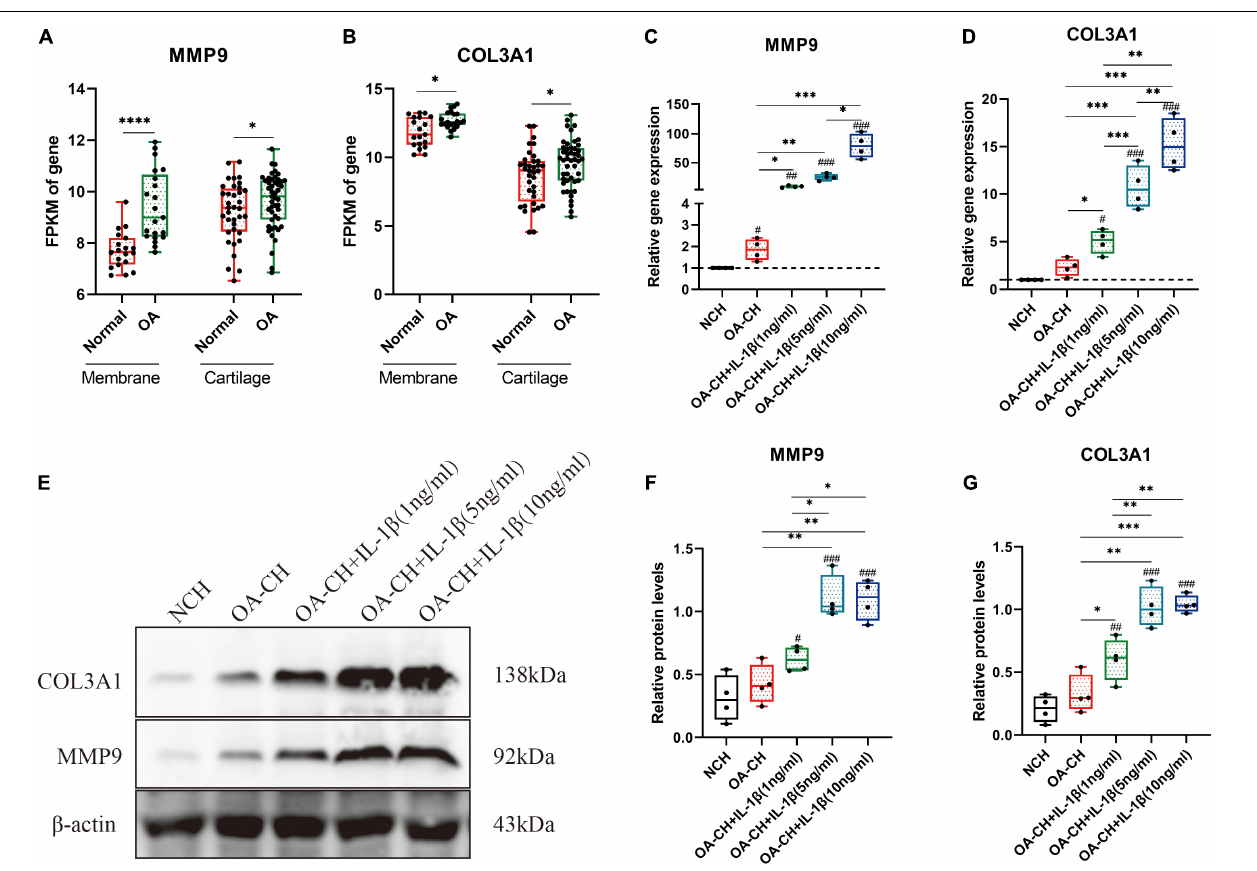
FIGURE 6 | Validation of the hub genes ( COL3A1 and MMP9 ) by quantitative reverse transcription PCR (qRT-PCR) and Western blotting. (A,B) Fragments per kilobase of exon model per million mapped fragments (FPKM) of COL3A1 and MMP9 in synovial membrane and cartilage samples. ∗ p < 0.05; ∗∗∗∗ p < 0.001, unpaired Student’s t -test. (C,D) Gene expression levels of COL3A1 and MMP9 in non-osteoarthritic chondrocytes (NCH) and osteoarthritic chondrocytes (OA-CH) treated with different concentrations of IL-1 β . (E–G) Western blotting was used to determine the protein expression levels of COL3A1 and MMP9 in NCH and OA-CH treated with different concentrations of IL-1 β . Significant difference to control (NCH): # p < 0.05; ## p < 0.01; ### p < 0.001. ∗ Significant difference between groups: ∗ p < 0.05; ∗∗ p < 0.01; ∗∗∗ p < 0.001. One-way ANOVA with Newman–Keuls multiple comparison test. All values represent the mean ± standard deviation ( n =